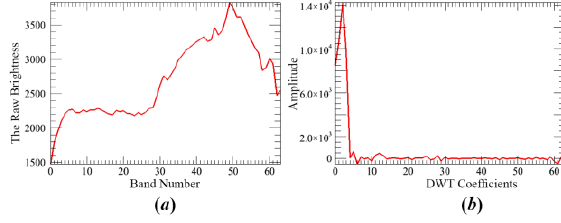
Figure 2. (a) A spectrum pixel of a hyperspectral image, (b) 4-level DWT of the main signal.